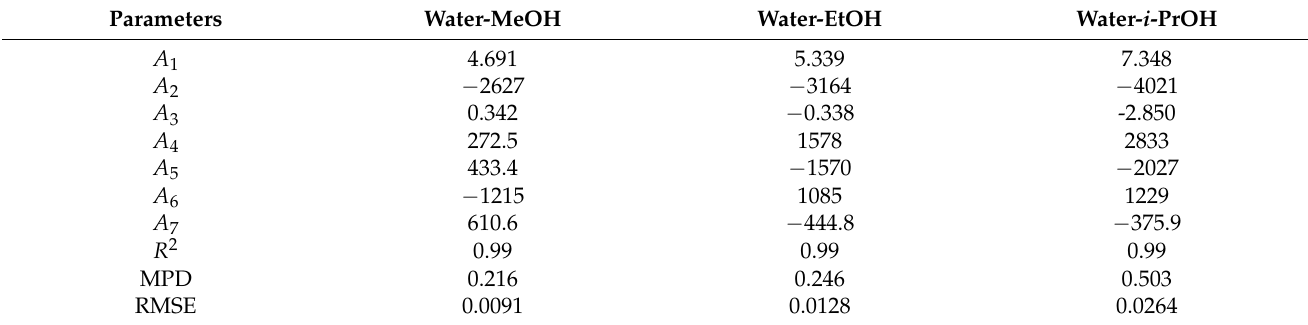
Table 2. Jouyban-Acree model parameters (Equation